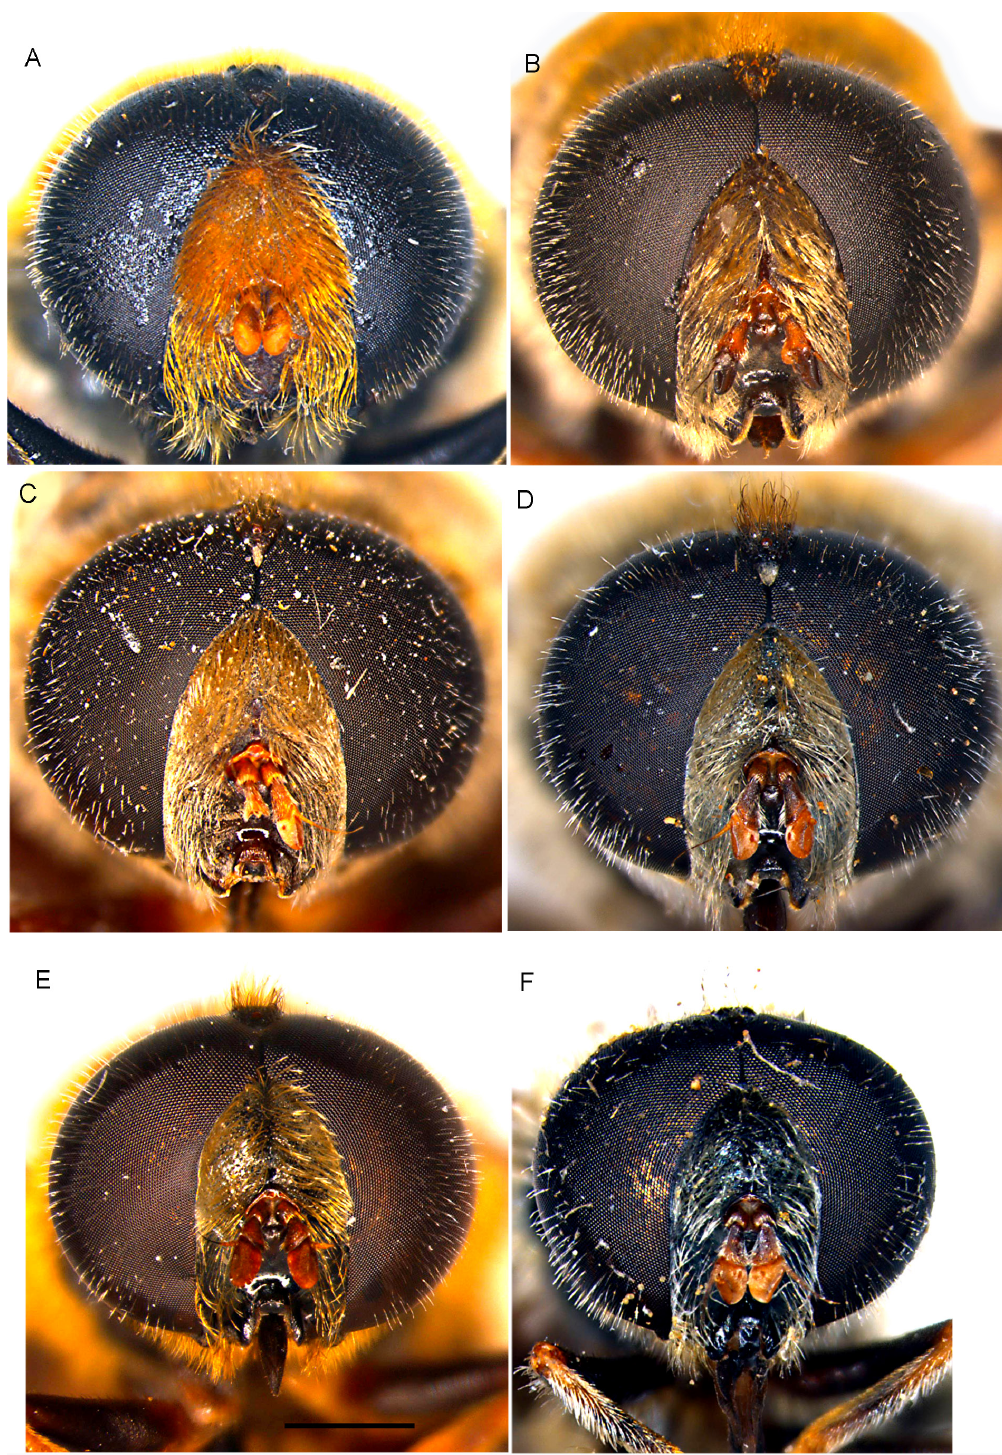
Fig. 11. Male head, frontal view. A . Merodon bombiformis Hull, 1944 (FSUNS; FSUNS ZA2_079). B . M. multifasciatus Curran, 1939 (USNM 2052372; FSUNS ID 04512). C . M. vittatus Vujić & Likov sp. nov., holotype (NBCN; FSUNS ID 04085). D . M. zebra Vujić & Radenković sp. nov., holotype (RMCA; FSUNS ID 25089). E . M. lotus Vujić & Radenković sp. nov., paratype (FSUNS; FSUNS ID ZA6_066). F . M. nasicus Bezzi, 1915 (TAUI; FSUNS ID 04972). Scale bar = 2